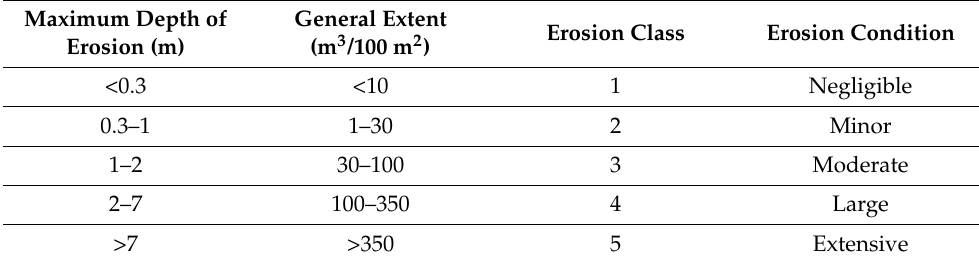
Table 3. Classification of erosion proposed by Pells [1].